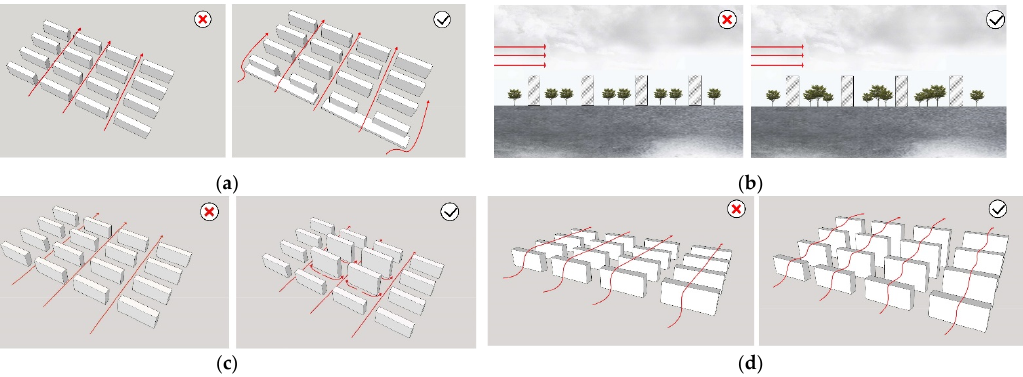
Figure 12. Morphology-optimization strategies for pollutant dispersion: ( a ) BED solution; ( b ) GCR solution; ( c ) ABV solution; ( d ) SDH solution.